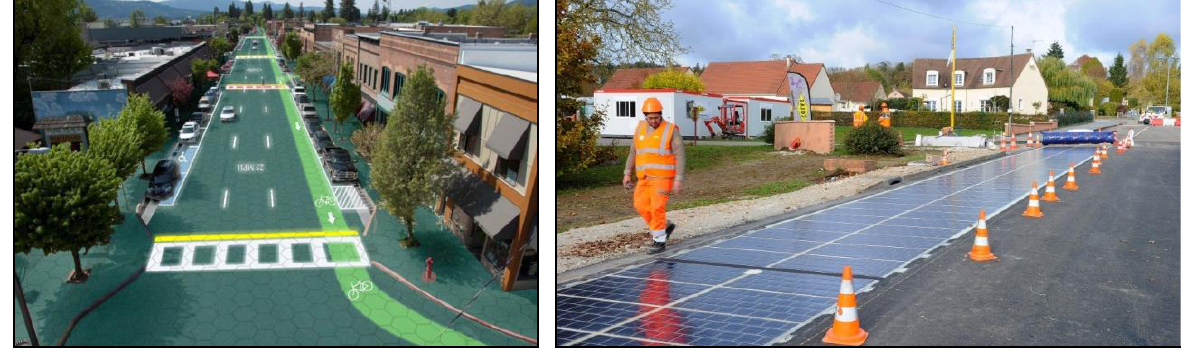
Figure 2. Solar Roadways pavement. Figure 3. Wattway panells